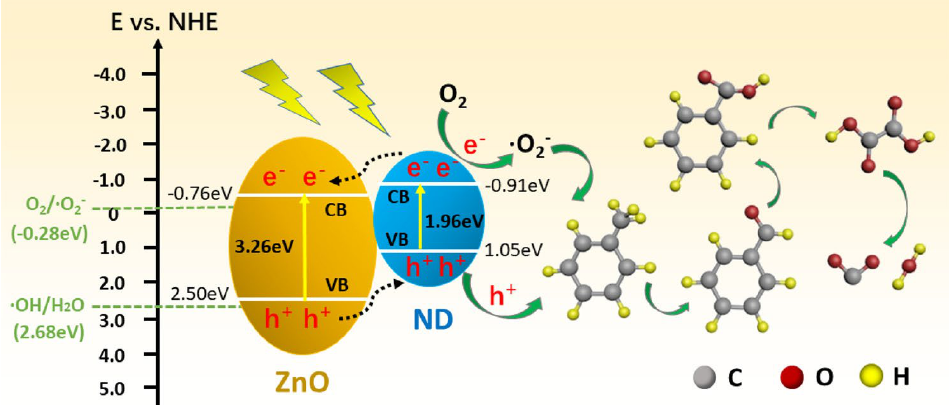
Figure 7. Proposed mechanism for photocatalytic degradation of toluene upon ND-decorated ZnO photocatalysts. Reproduced with permission from ref. [60]. Copyright 2019 Elsevier.